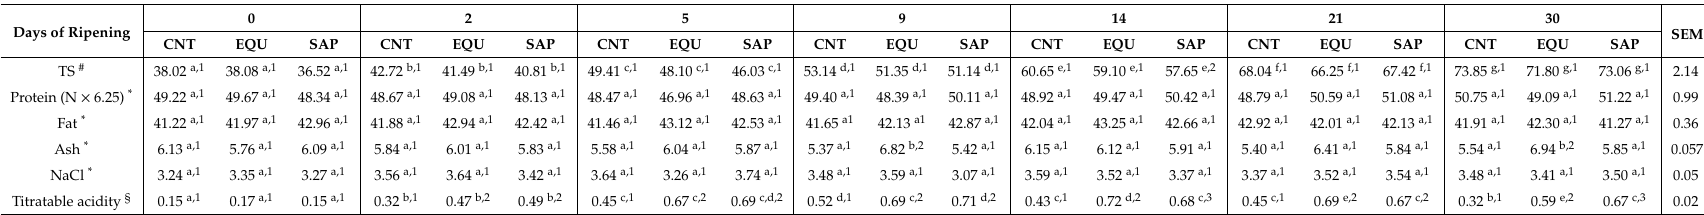
Table 1. Evolution of the proximate composition and titratable acidity along the manufacturing process of Galician chorizo made without and with starter cultures (means of three replicates in each sausage group).